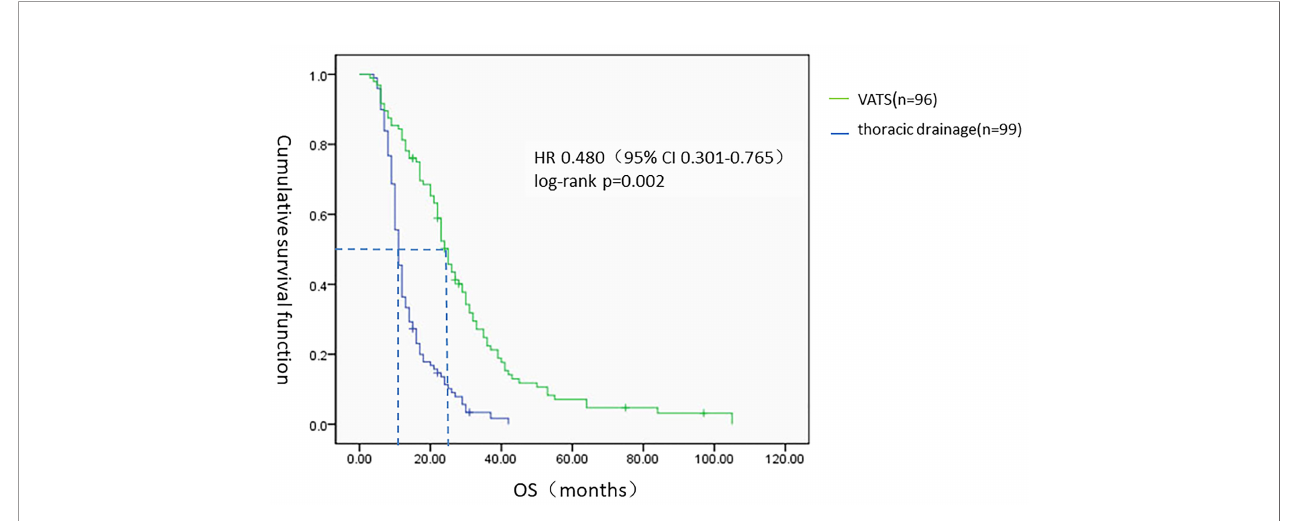
FIGURE 3 | The Kaplan – Meier survival analysis of two groups. HR, hazard